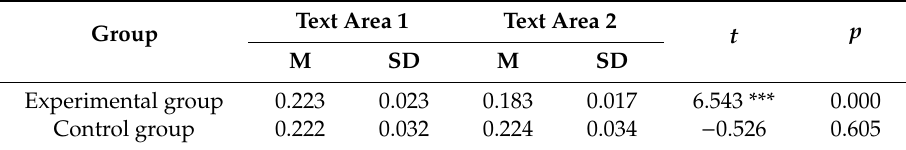
Table 3. The t -test results of mean fixation duration for the two